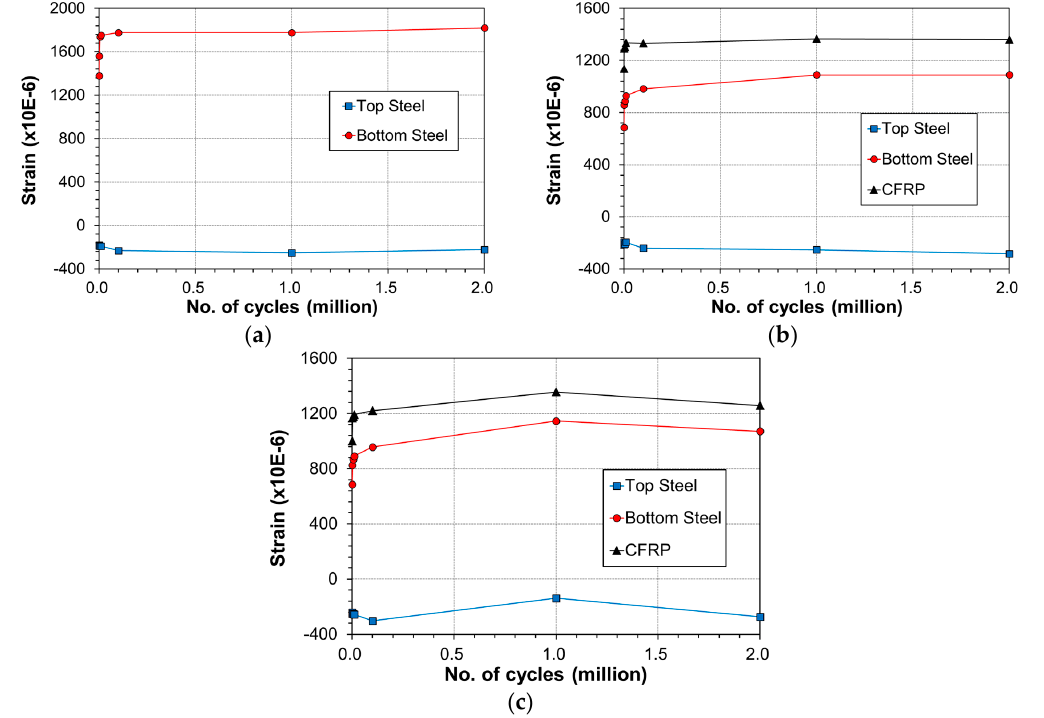
Figure 9. Variation of strain across the beam at mid-span with number of cycles: ( a ) control; ( b ) E-OX-1-30-80%; ( c ) E-OX-1-40-80%.